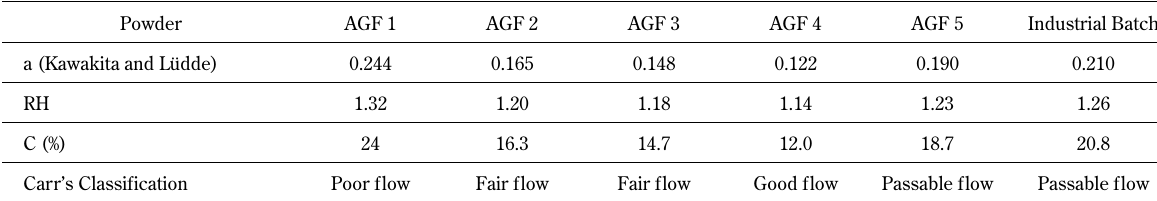
Table 4 Packing test